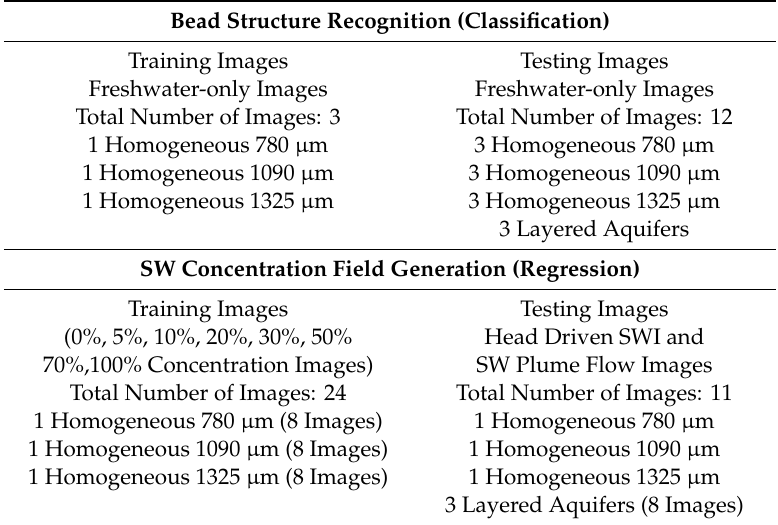
Figure 3. Flowchart of the proposed methodology depicting its three distinct parts ( a ) image pre-processing, ( b ) bead structure recognition and ( c ) saltwater field generation. Table 1. Experimental aquifer images used as training and testing datasets by the classification and regression machine learning algorithms.